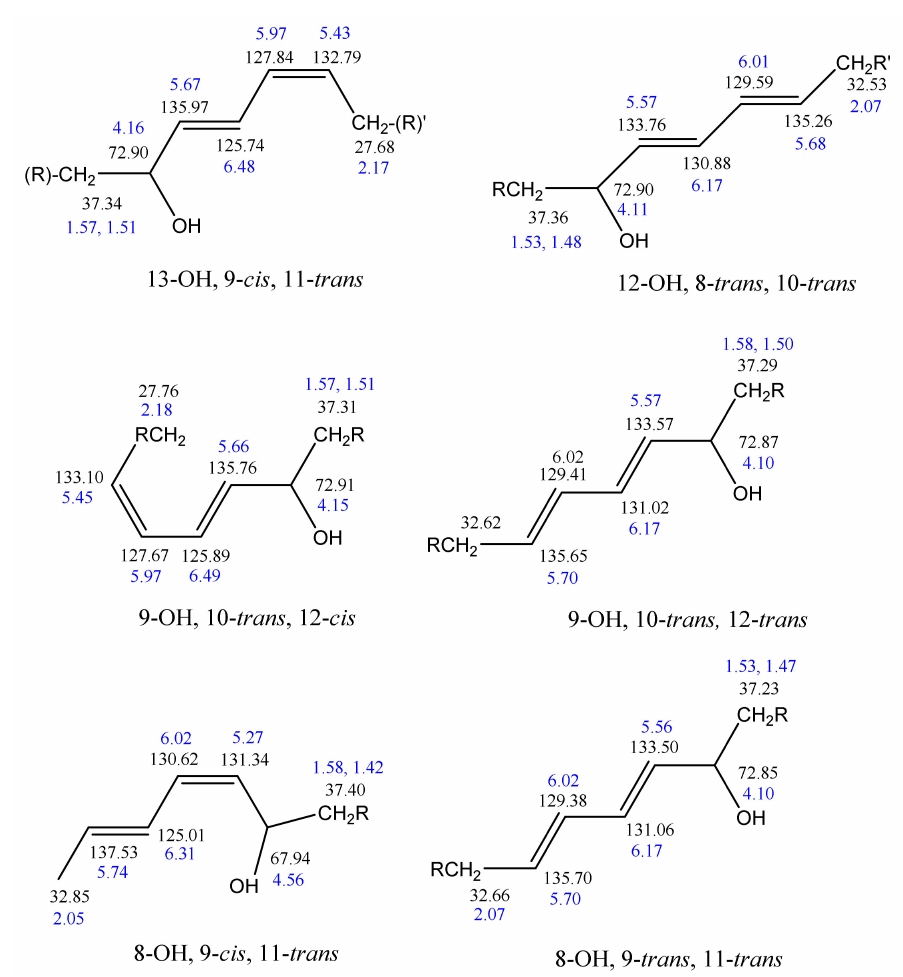
Figure 21. 1 H (blue color) and 13 C (black color) chemical shifts of various hydroxy-CLA methyl esters. High-resolution 1 H-NMR (600 MHz) was used to investigate oxidation products of ethyl ester all- cis 4, 7, 10, 13, 16, 19-docosahexaenoic acid (DHA), with and without added α -tocopherol. Correlations were found between primary oxidation products (PV and conjugated dienes) and 1 H resonances in the region of 8.0–10.5 ppm. The peaks from the aldehyde hydrogens were only observed in the absence of α -tocopherol. With the addition of α -tocopherol, eight very sharp resonances of the hydroperoxide protons (–OOH) were observed in the region of 8 to 9 ppm. In the absence of α -tocopherol, several additional weaker signals due to hydroperoxide protons were also observed. It was concluded that the identification of the –OOH protons could not be performed on the basis of 1 H-NMR chemical shifts [101]. The great potentialities of 1 H- 13 C HSQC and HMBC experiments to resolve ambiguities of resonance assignments, not only of chromatographically isolated hydroperoxides but also in mixture analysis, will be discussed in Section